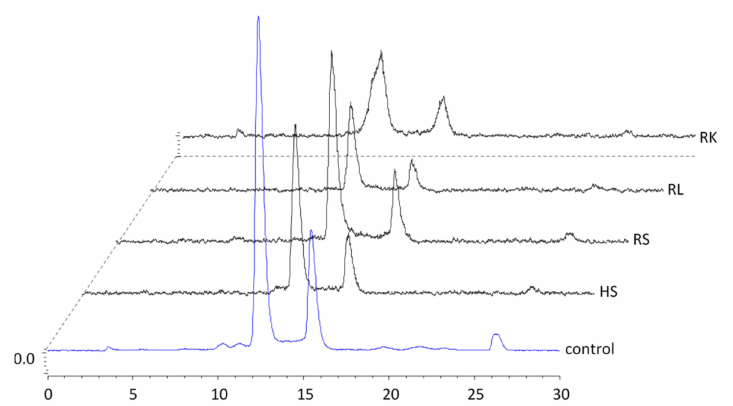
Figure 5. RP-HPLC of 99m Tc2 after incubation at 37 ◦ C for 4 h in: (HS) human serum; (RS) rat serum; (RL) rat liver homogenate; (RK) rat kidney homogenate. The activity peaks of all samples were coincident with the control peaks, and no variations in the a-to-b isomeric ratio were observed, indicating that there is not a preference from peptidase towards one of the two